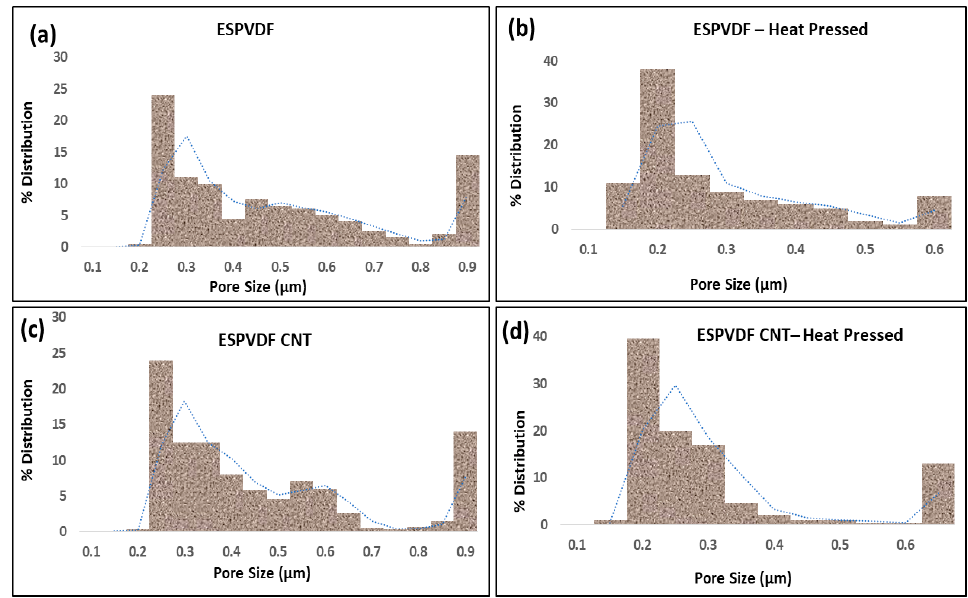
Figure 3. Percentage pore size distribution of the electrospun PVDF ‐ Co ‐ HFP and CNT ‐ modified PVDF ‐ Co ‐ HFP membranes before and after heat pressing ( a ) Pristine electrospun membrane before heat pressing, ( b ) Pristine electrospun membrane after heat pressing, ( c ) CNT ‐ coated electrospun membrane before heat pressing, and ( d ) CNT ‐ coated electrospun membrane after heat pressing.